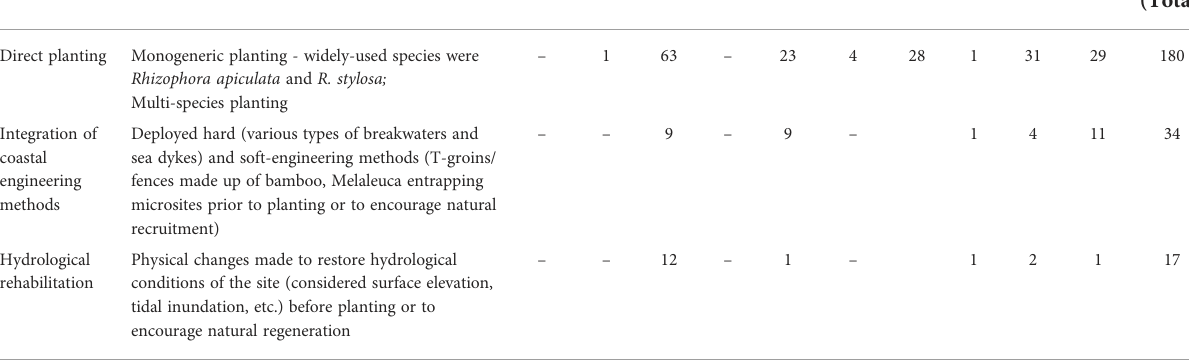
TABLE 4 Mangrove restoration techniques from each country and in SE Asia.